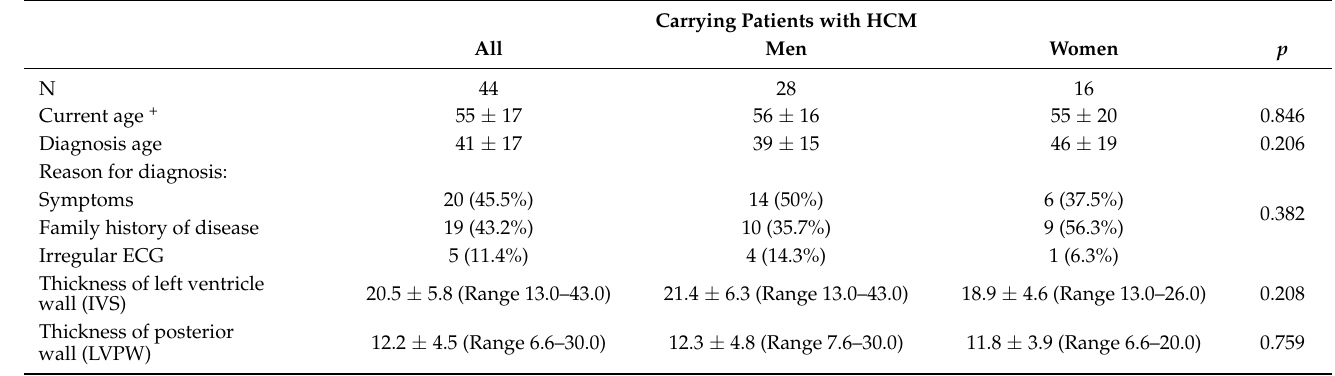
Table 1. Characteristics of the 44 affected hypertrophic cardiomyopathy carriers of MYBPC3 p.Val931Glyfs*120. Unless otherwise indicated, data are expressed as: Nº (%) or Yes/No (% Yes) or mean ± standard deviation 1. + Deceased patients are excluded from the calculation of the average age.